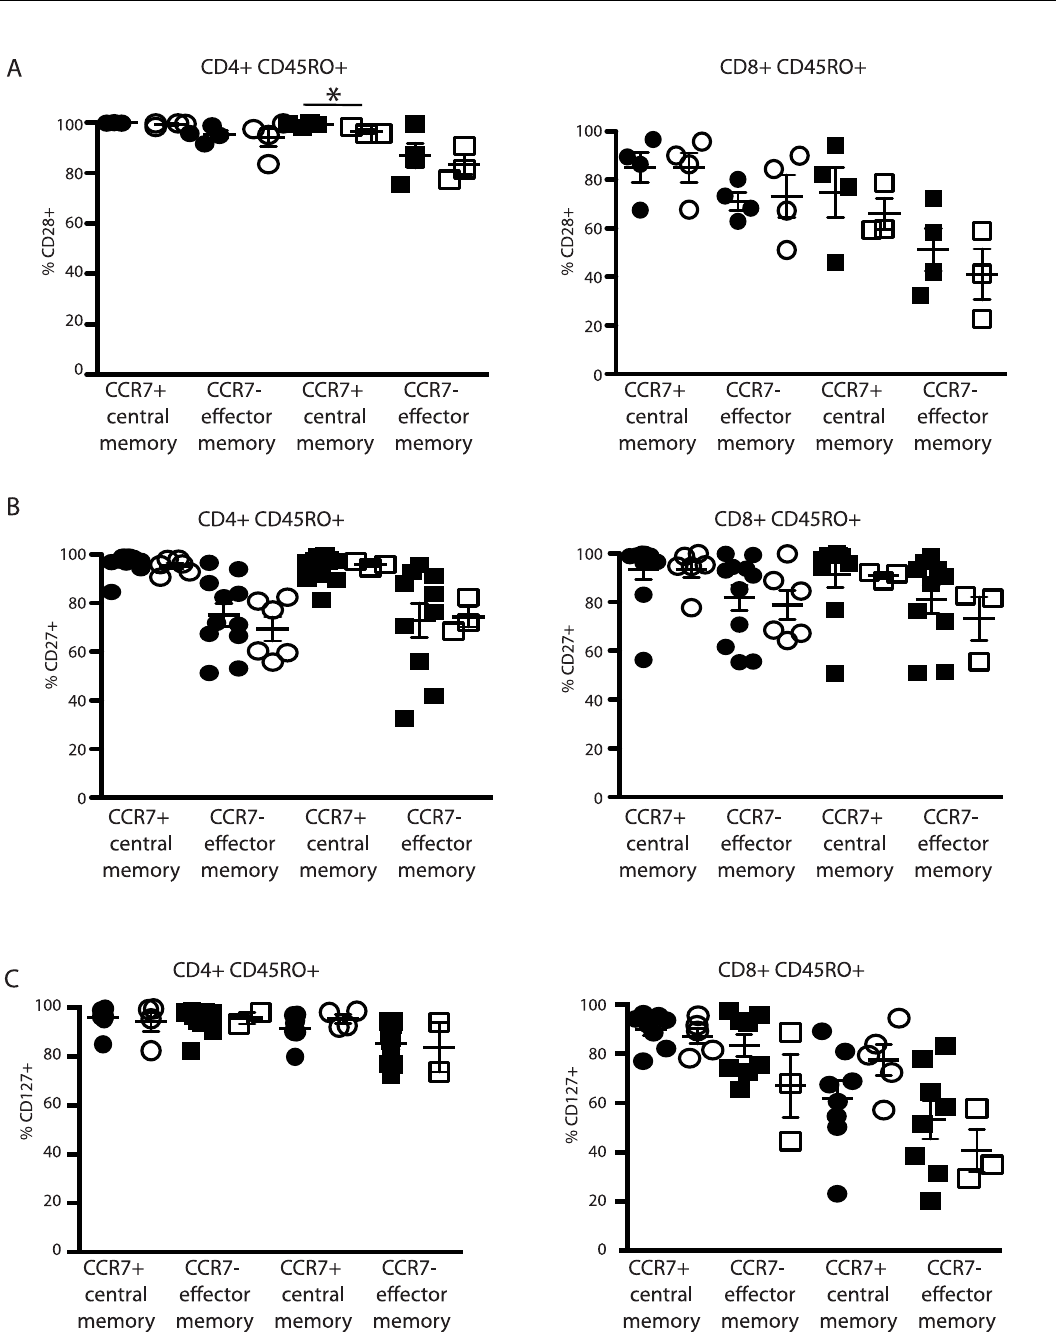
Fig 2. Memory T cells from preeclamptic patients do not display surface markers of exhaustion. Fresh peripheral blood and UPI samples from healthy3 rd trimester pregnantwomen and preeclamptic women was processedand analyzedas describedin materials and methods. CD28 (A) and CD27 (B) percentage of CD4+ memory (left side) or CD8+ memory (right side), CCR7+ or—cells was determined[7]. Student’sT test,